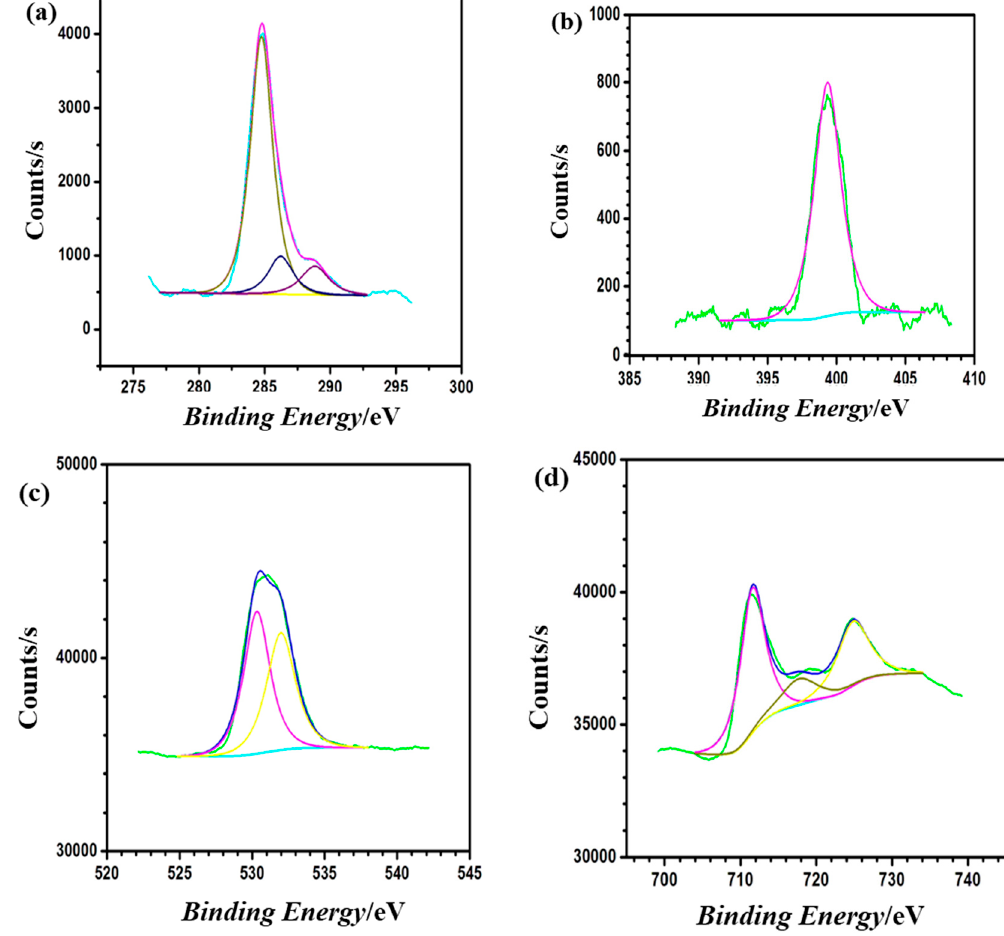
Figure 5. XPS spectra: ( a ) C 1s, ( b ) N 1s, ( c ) O 1s and ( d ) Fe 2p of the TMI inhibitor.